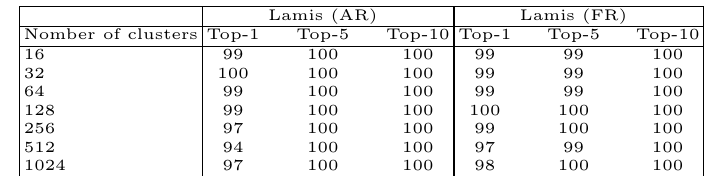
Table 1. Classification results using the VLAD encoding system with the concatenation of the two horizontal (h) and vertical (v)